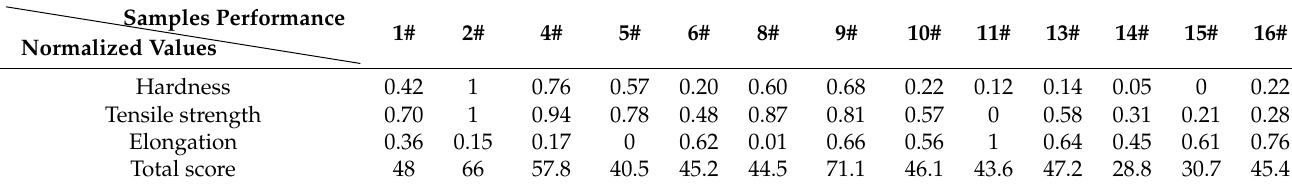
performance is shown in Table 3. Due to the positive relationship of hardness and tensile strength, the index weight was set to 30%, 30% and 40% to obtain the total performance score, respectively. The final performance score in Table 2 was taken from Table 3. Table 3. Performance evaluation